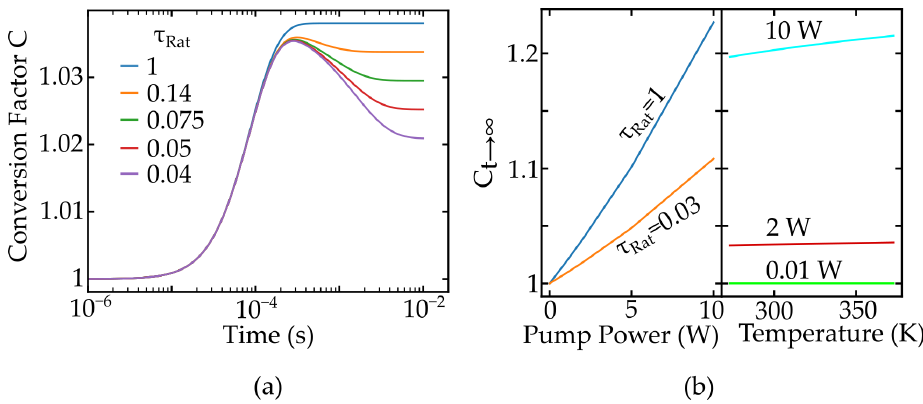
Figure 7. Conversion factor C depending on time and the ratio of lifetimes τ Rat of the lower laser levels in ( a ), and shown in ( b ) is the value of C for long times depending on the temperature and the pump power.